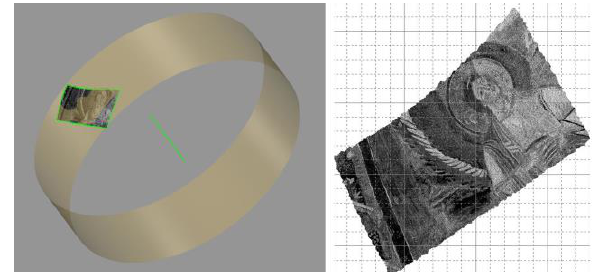
Figure 10. On the left: best fitting cylinder of one of the segmented 3D mesh and its central axis. On the right: orthoprojection of a portion of the 3D